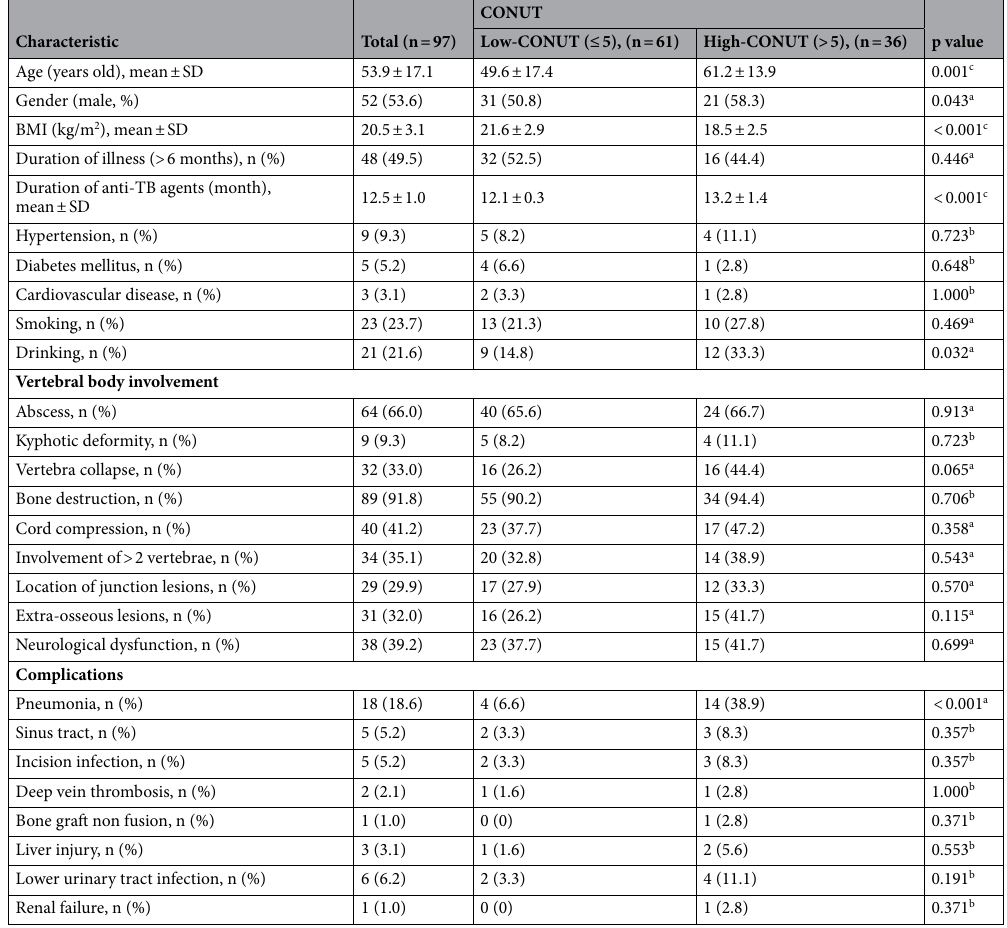
Table 3. Characteristic in patients with different CONUT. CONUT controlling nutritional status, BMI body mass index, SD standard deviation. a χ 2 test. b Fisher’s exact test. c Independent Sample T-test.